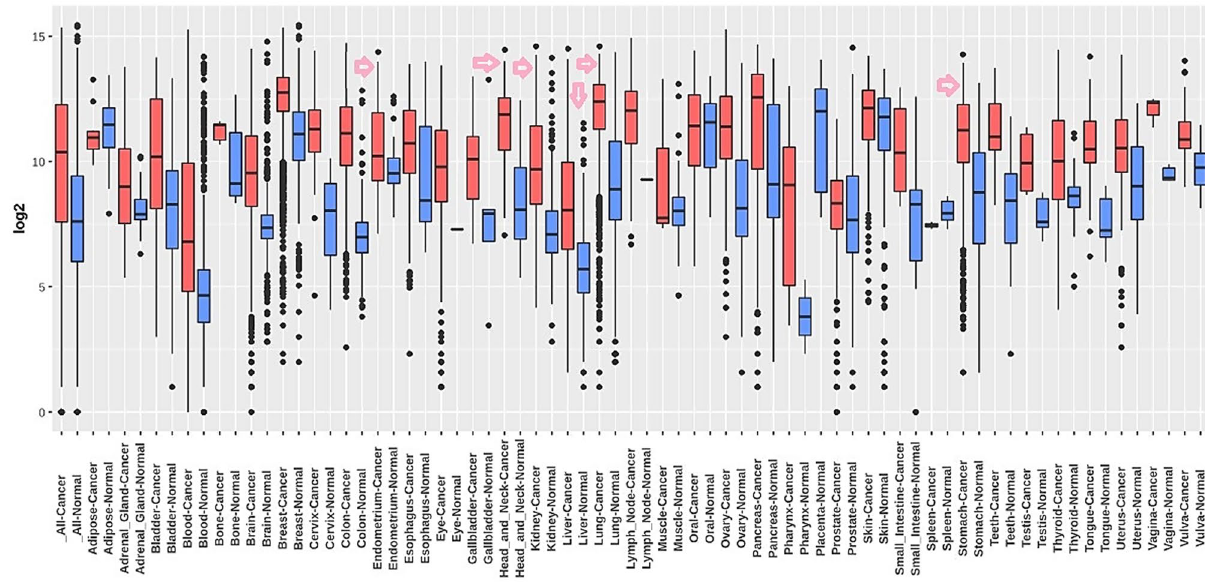
Figure 10. Transcription expression level validation of CTHRC1 using independent HNSC, KIRC, LIHC, LUAD, STAD, and UCEC cohorts via GENT2 database. A p-value of < 0.05 was selected as a cutoff criterion.